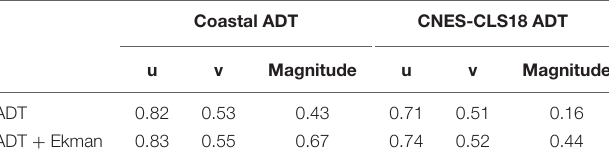
TABLE 1 | Correlation coefficients between the components of the currents from the ADT (by using the coastal and the CNES-CLS18 MDTs and with/without including Ekman current) and the mean HF radar considering, for